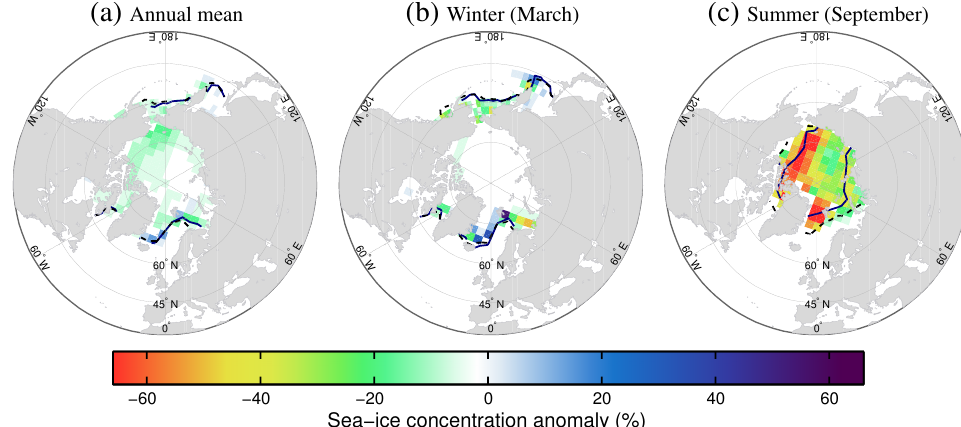
Figure 2. Mean annual, winter (March) and summer (September) MH sea ice concentration anomalies (in %, with respect to the PI reference period) and location of the ice edge for 6ka (solid lines) and for the PI period (dashed lines), defined as 15% concentration limits, as simulated by LOVECLIM without data